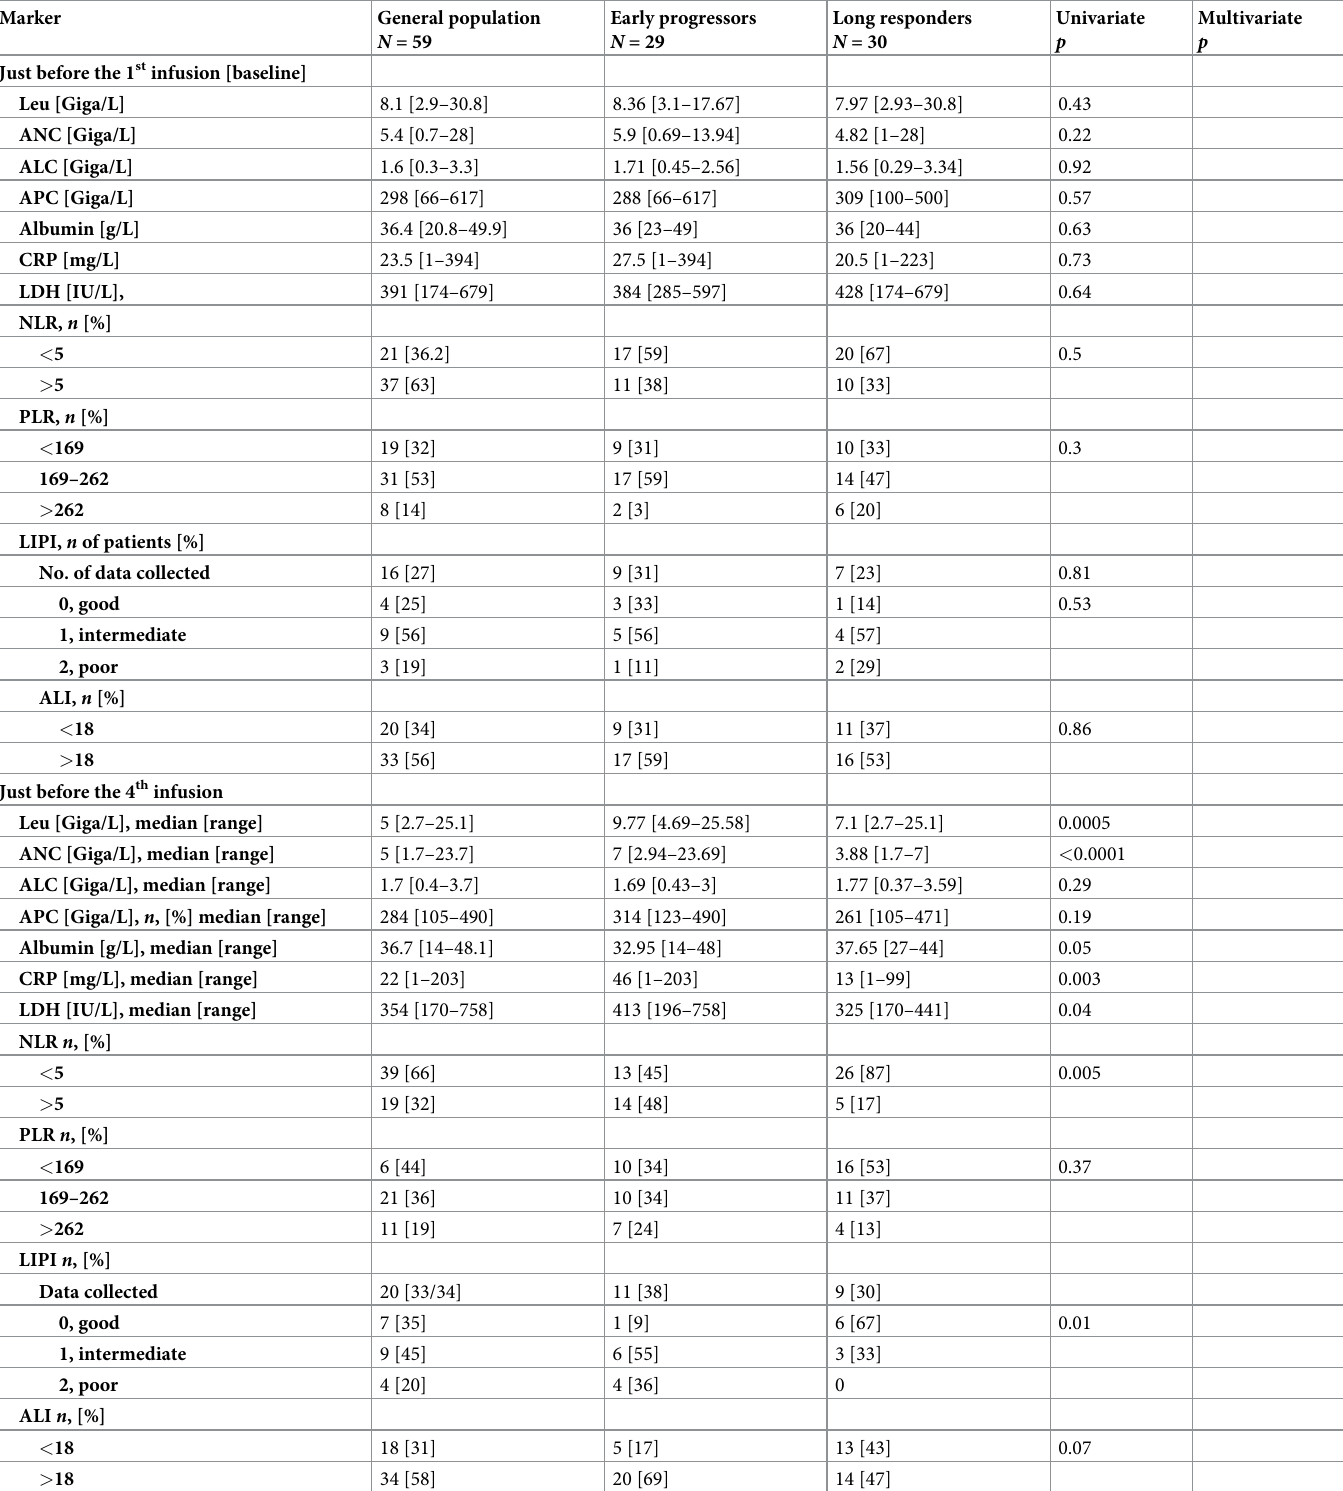
Table 2. NSCLC patients’ biomarker values at the 2 times of